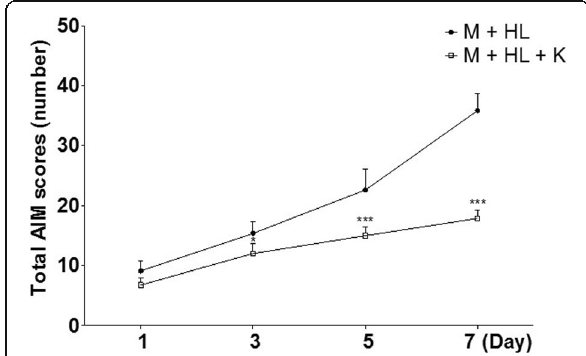
Fig. 8 Effects of combination treatment on dyskinesia induced by dopa. AIMs were measured 20 min after the administration of (20 mg/kg). M: MPTP, K: KD5040, HL: high dose of *** p < 0.001 and * p < 0.05 vs. MPTP +